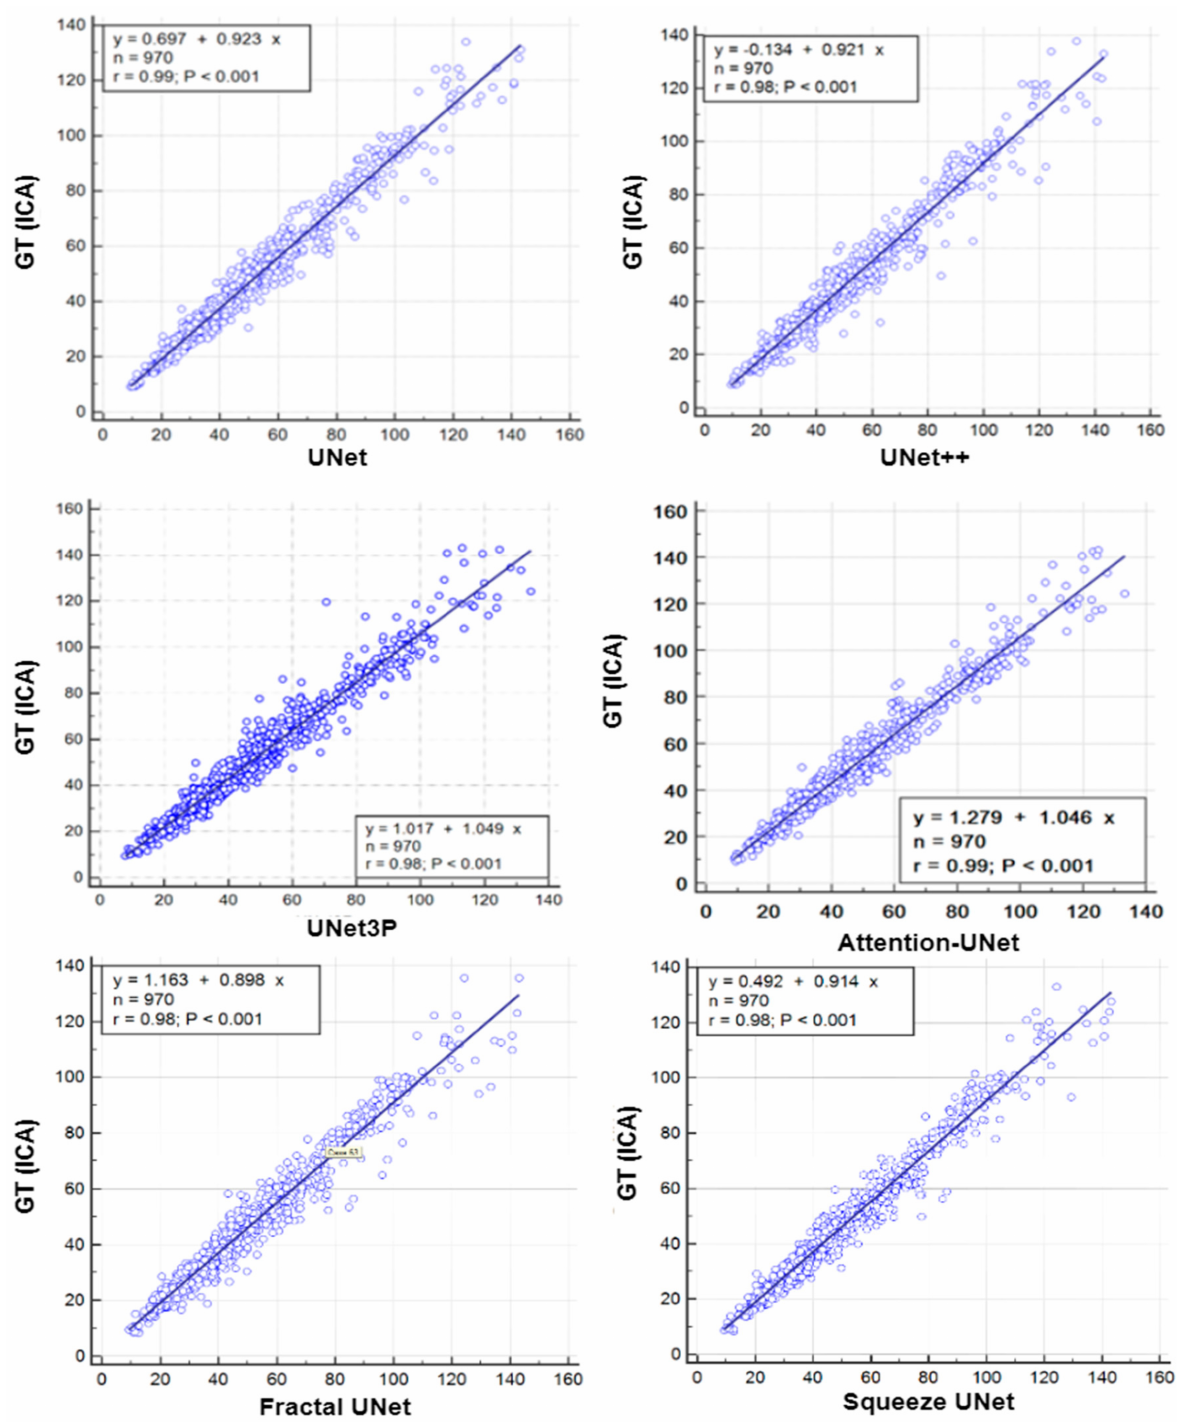
Figure 10. Regression plots for all 6 types of UNet models for ICA DB1